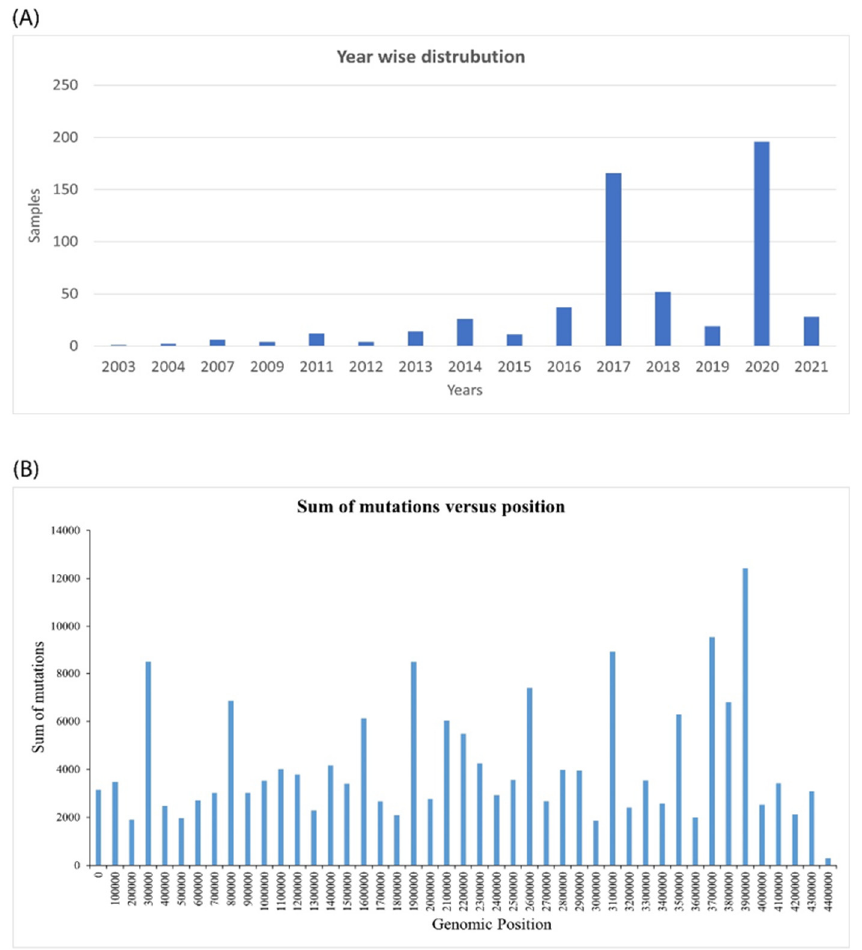
Figure 1. Mycobacterium time series analysis. ( A ) Year-wise distribution of samples collected from the NCBI database. ( B ) The mutations of Mycobacterium tuberculosis over the time series can be cu- mulatively plotted versus the genomic positions.